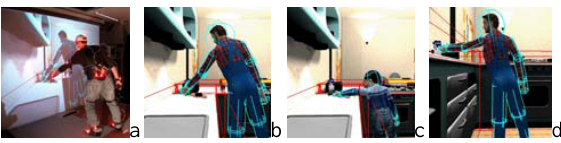
Figure 1. (a) immersive display with active marker motion capture system, (b) the controlled same-height avatar, (c) controlling a child avatar with the same visual scale as in a and b, (d) egocentric scaling strategy: the virtual environment is scaled as experienced by the child avatar